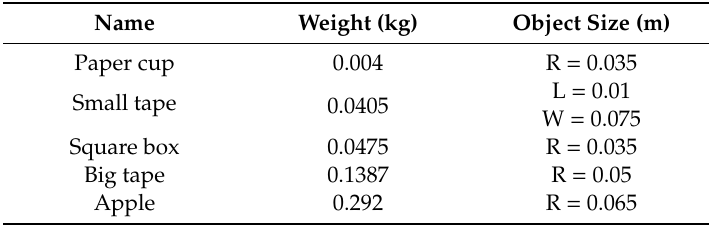
Table 4. The objects used for the experiment. R is radius, L is length, and W is width. The dimensions were measured in the same position as they would be presented during the grasping